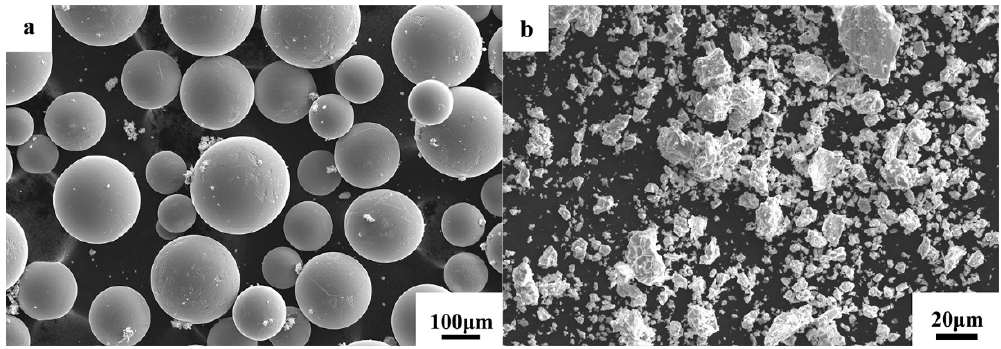
Figure 1. SEM micrographs of ( a ) TC11 powders and ( b ) ZrN